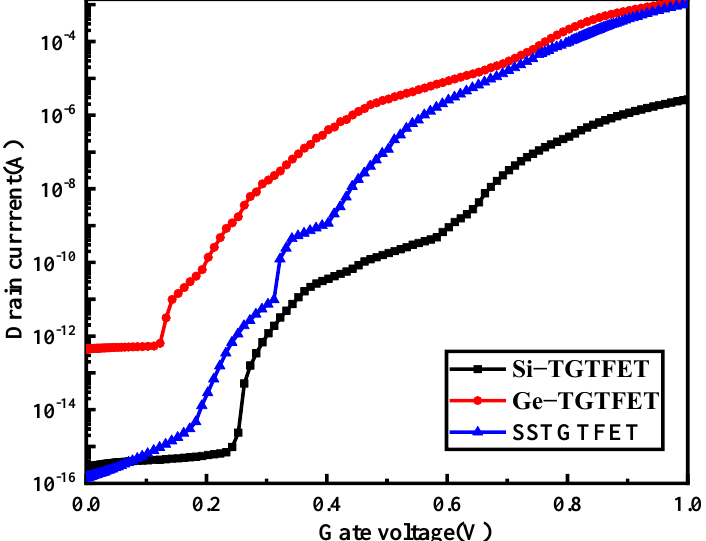
Figure 2. Transfer characteristics for Si − TFET, Ge − TFET and SSTGTFET at V d = 1 V. The preparation process of EETGTFET is similar to the structure in Ref. [26]. Figure 3 shows the process flow of DM-SSTGTFET. Figure 3(i) is a brief description of Figure 3(a) – (h).